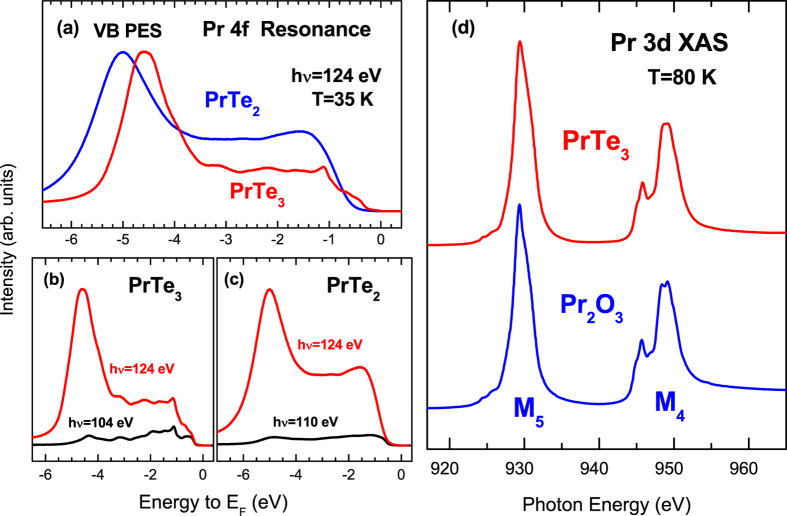
Pr 4 f RPES and Pr 3d XAS spectra of PrTe3.(a) Angle-integrated valence-band Pr 4d → 4 f resonant photoemission spectroscopy (RPES) spectrum of PrTe3, in comparison with that of PrTe2. Both data were obtained at the Pr 4 f resonance energy (hν = 124 eV). (b) Comparison of the Pr 4d → 4 f RPES spectra of PrTe3, obtained with hν = 124 eV (on-resonance) and hν = 104 eV (off the resonance), respectively. (c) Similarly for PrTe2, obtained with hν = 124 eV (on-resonance) and hν = 110 eV (off the resonance), respectively. The PES spectra were obtained at T = 35 K and were normalized to the incident photon flux. (d) Comparison of the Pr 3d XAS spectrum of PrTe3 with that of Pr2O3, obtained at T = 80 K.